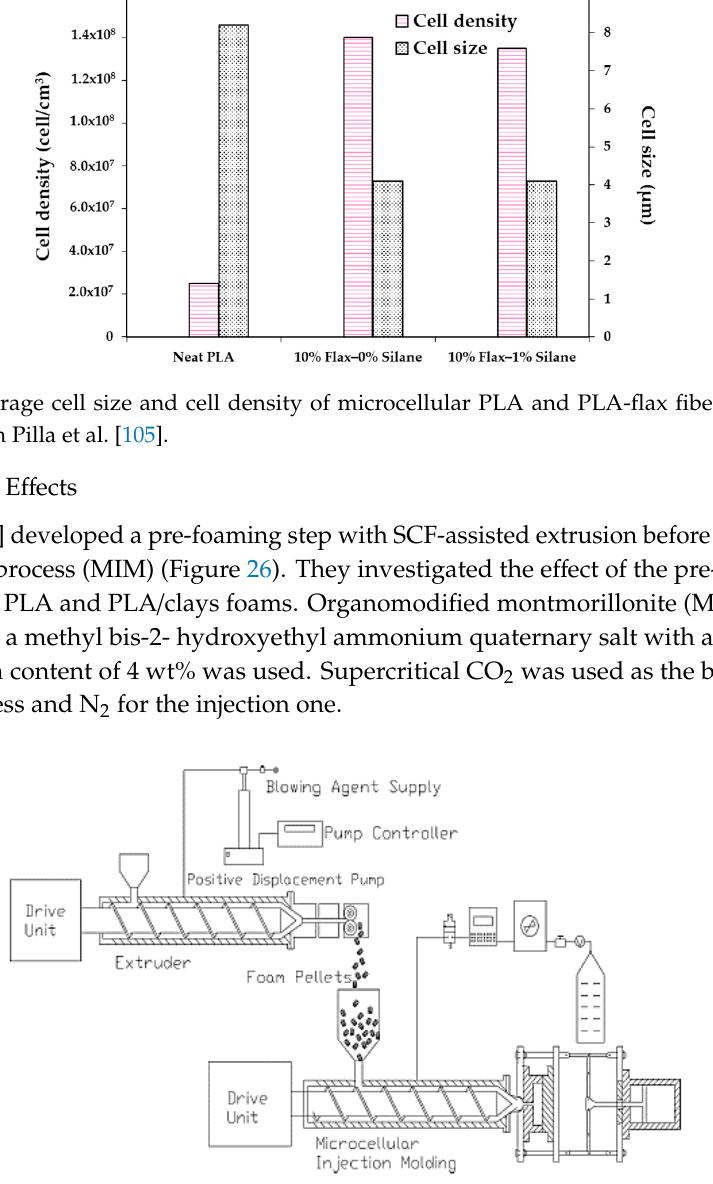
Figure 26. Schematic of microcellular injection molding combined with the pre-foaming extrusion process developed by Zhao et al. Reprinted from Zhao et al. [90]. Copyright (2020) American Chemical Society.